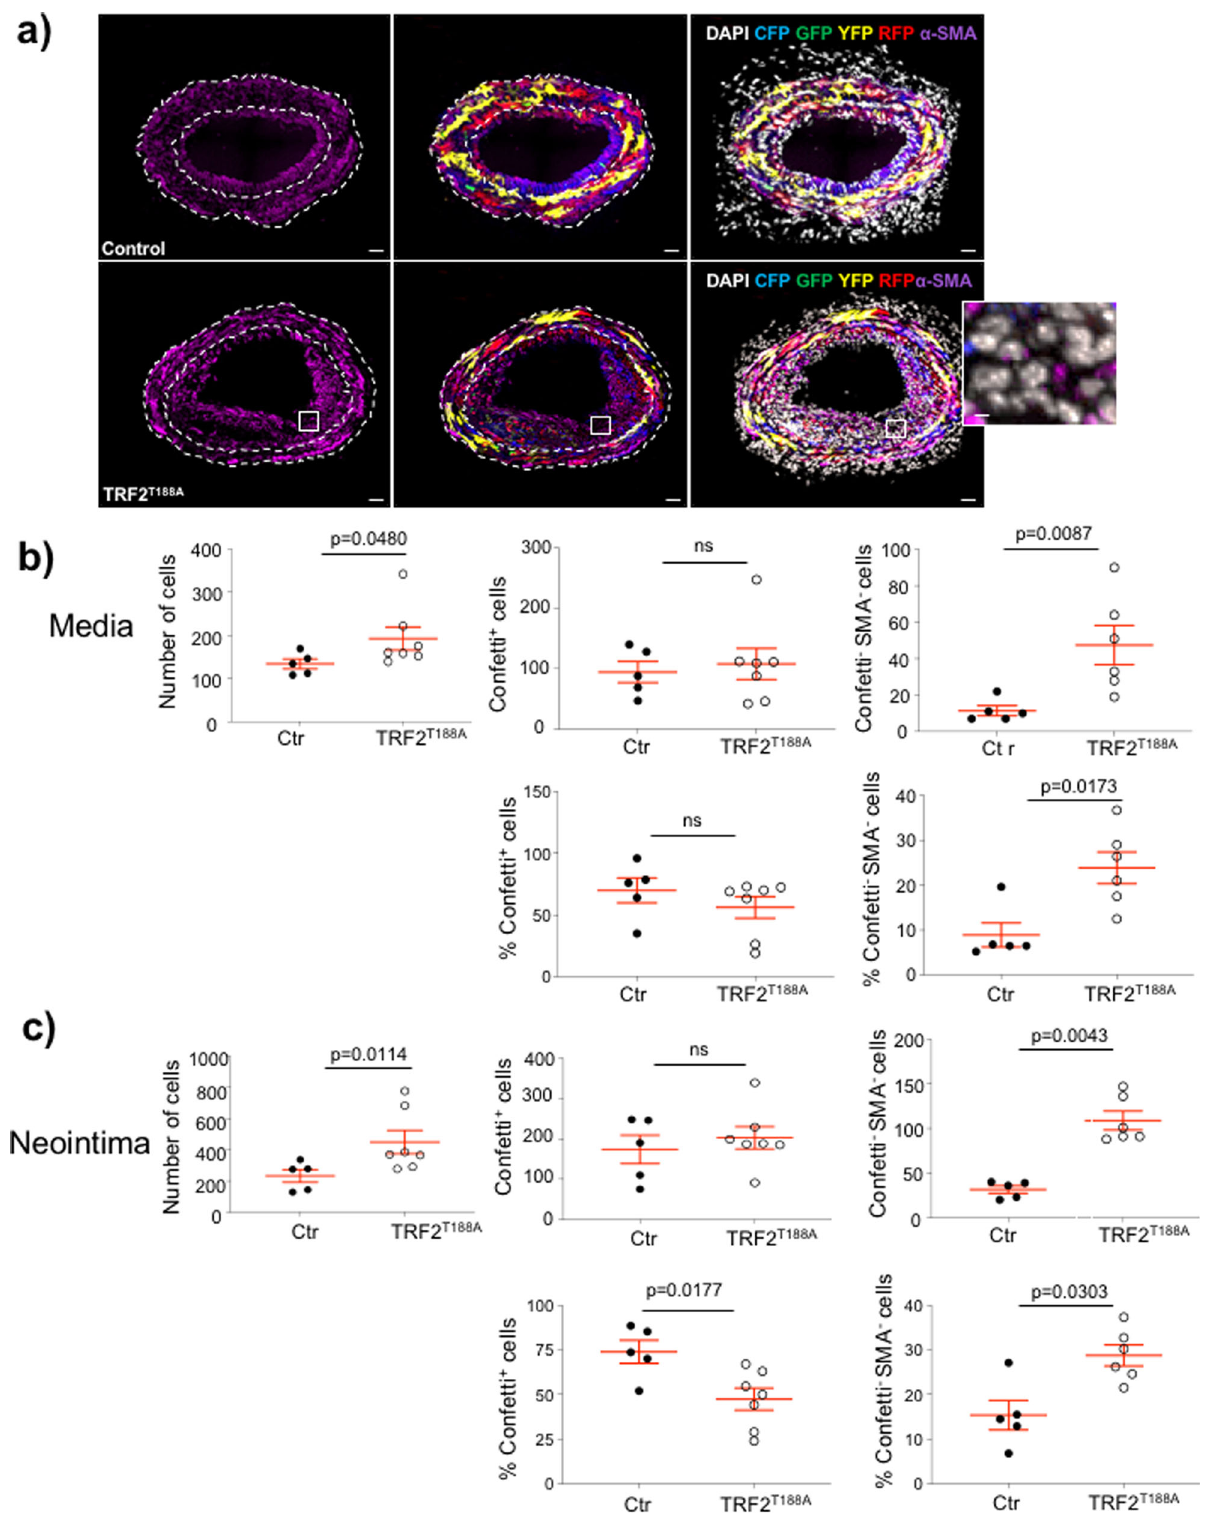
Fig. 6 Telomere damage promotes accumulation of cells of non-VSMC origin in media and neointima. a Immunohistochemistry of LCCAs of TRF2 T188A and control mice 28d post ligation for confetti + cells, α -SMA (magenta), and DAPI (white). Outlined regions show magni fi ed confetti − / α SMA − cells. Scale bar = 30 μ m and 5.6 μ m (inset). Overall number and % of cells (DAPI), confetti + VSMCs, and confetti − / α SMA − non-VSMCs in the b media or c neointima. Data represent means±SEM, n ≥ 5 mice per group, ns-non signi fi cant ( p > 0.05), unpaired, two-tailed Student ’ s t test or Mann – Whitney U